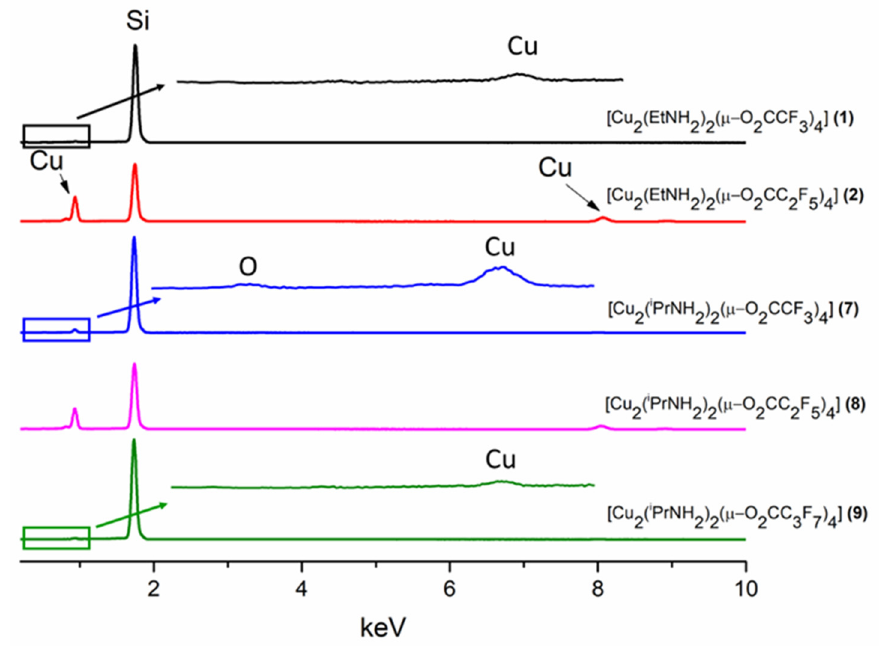
Figure 12. Composition analysis of the obtained materials using precursors: [Cu 2 (EtNH 2 ) 2 (µ-O 2 CCF 3 ) 4 ] ( 1 ) (black line) , [Cu 2 (EtNH 2 ) 2 (µ-O 2 CC 2 F 5 ) 4 ] ( 2 ) (red line) , [Cu 2 ( i PrNH 2 ) 2 (µ-O 2 CCF 3 ) 4 ] ( 7 ) (blue line) , [Cu 2 ( i PrNH 2 ) 2 (µ-O 2 CC 2 F 5 ) 4 ] ( 8 ) (pink line) , [Cu 2 ( i PrNH 2 ) 2 (µ-O 2 CC 3 F 7 ) 4 ] ( 9 ) (green line) .